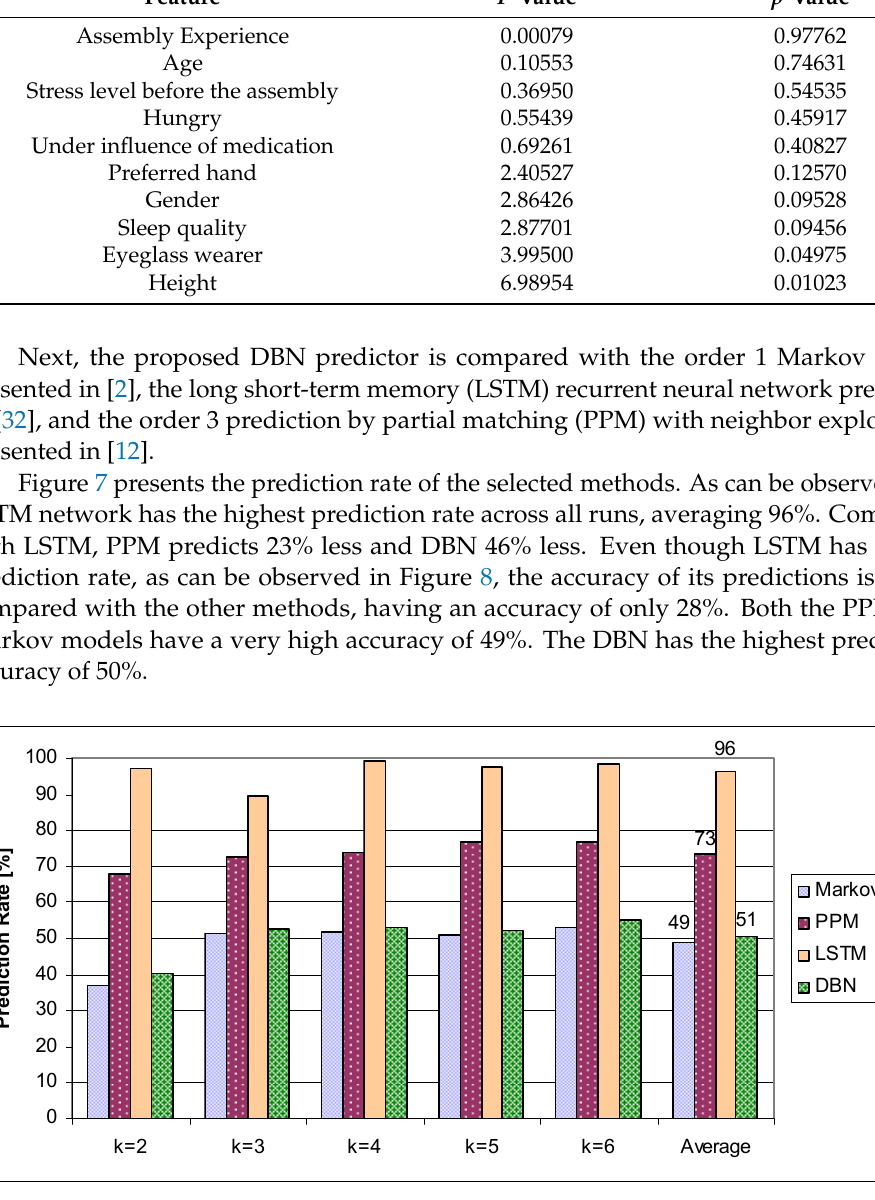
Figure 8. Prediction accuracy without the mood variable through k ‐ fold cross ‐ validation. The coverage is strongly correlated with the prediction rate (see Figure 9). Surprisingly, the best coverage of 36% is obtained by using the PPM implementation. The LSTM has a coverage of only 27%, despite its high prediction rate. The DBN has a coverage of 26%, slightly higher than the Markov model’s 24%.